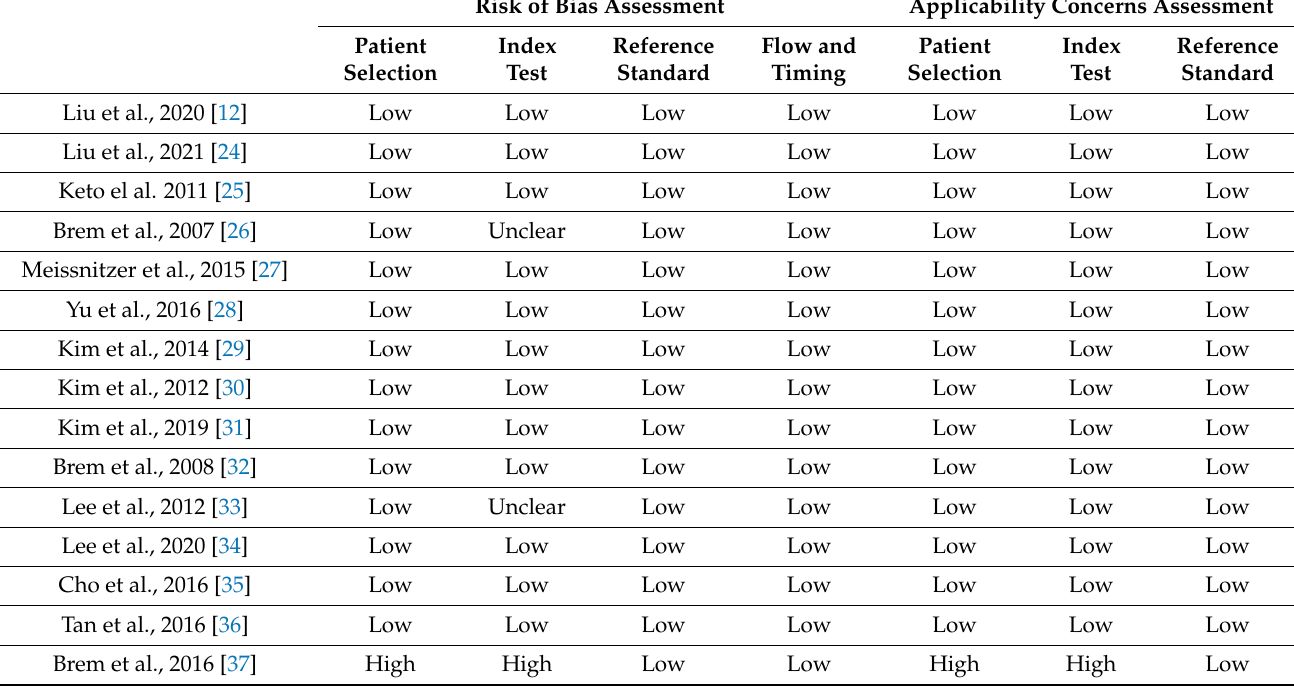
Table 4. QUADAS 2 score of all included